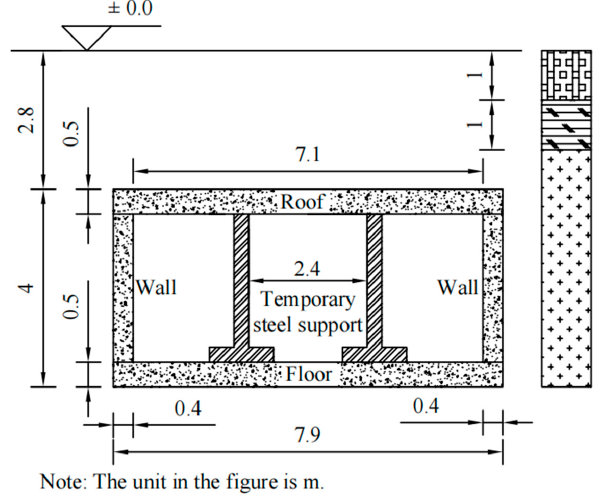
Figure 4. The profile of the underground civil air defense construction [35].